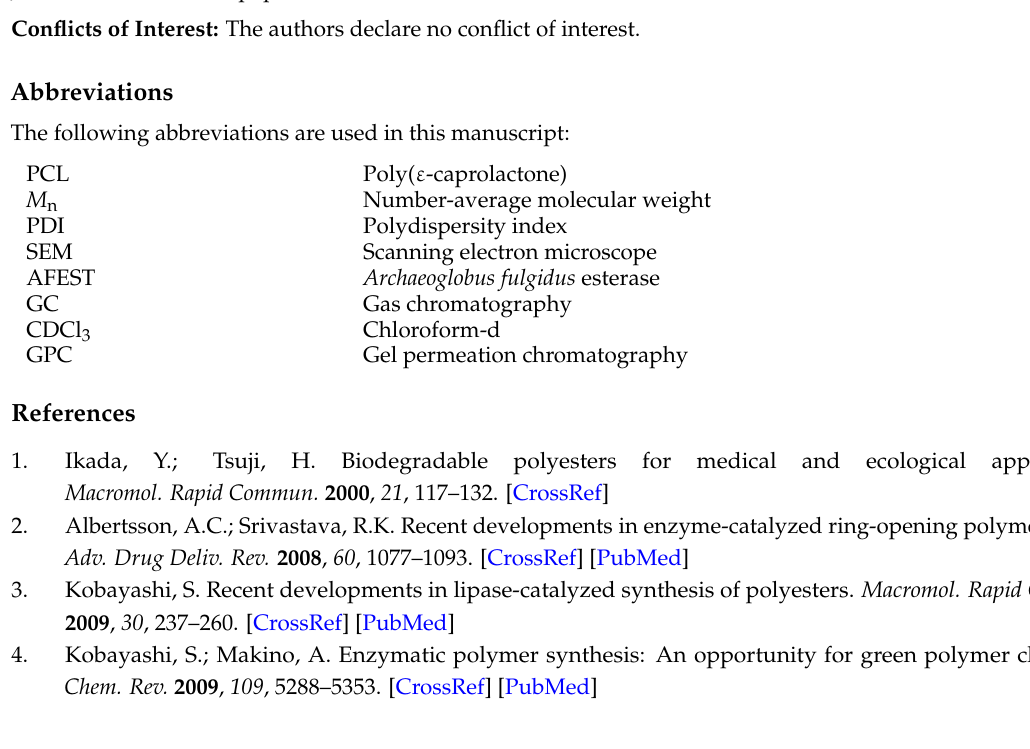
Figure S1: 1 H NMR spectrum of PCL synthesized by the immobilized enzyme EC-EP-AFEST; Figure S2: Typical GC chromatograph for determining the monomer conversion; Figure S3: Typical GPC chromatograms of polystyrene standard with M n = 2000 g/mol (A) and PCL synthesized by the immobilized enzyme EC-EP-AFEST